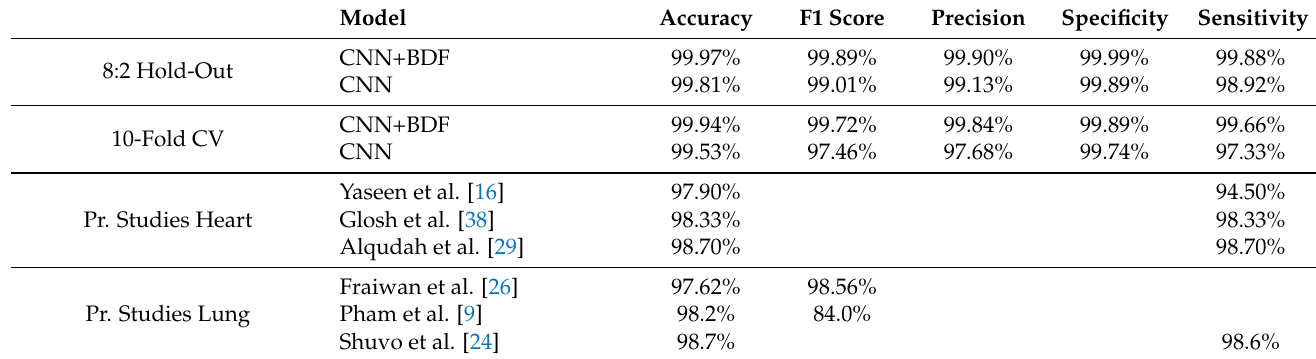
Table 3. Performance expressed in percent of the hybrid model and of the pure CNN model based on 8:2 hold-out and 10-fold cross validation with comparisons.